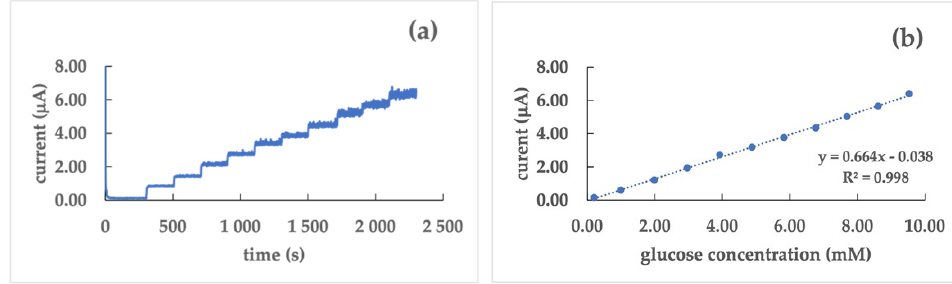
Figure 5. Current/time response ( a ) and calibration curve ( b ) of the GC/poly(dTT − bT)/GrO/GOx biosensor in a phosphate buffer (0.1 M, pH 7.0) at a glucose concentration range of 0.2 ÷ 10 mM; working potential: 0.40 V vs. Ag/AgCl.